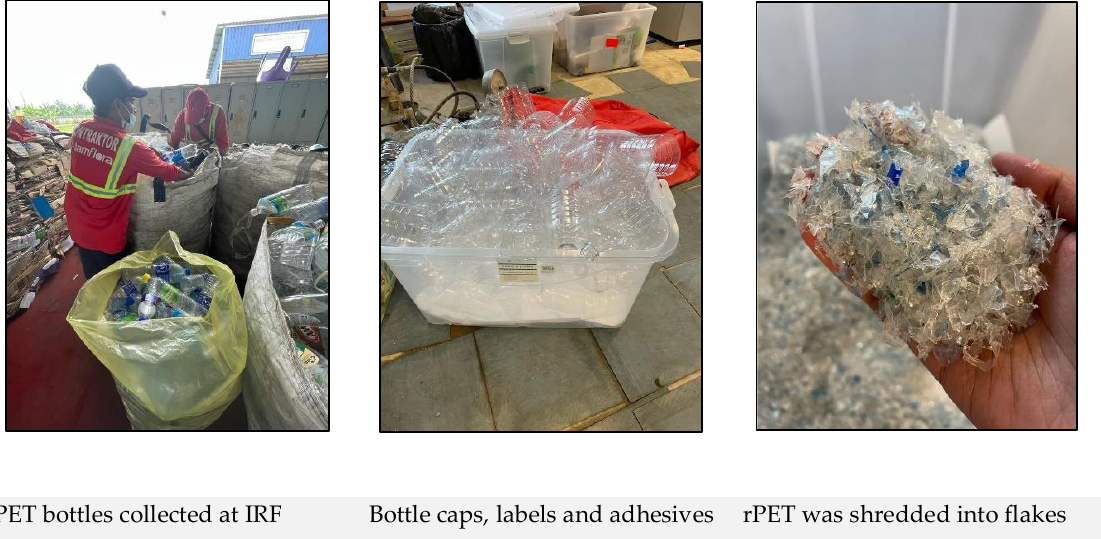
Bottle caps, labels and adhesives were removed Figure 4. The collection and processing of recycled PET (rPET). Figure 4. The collection and processing of recycled PET